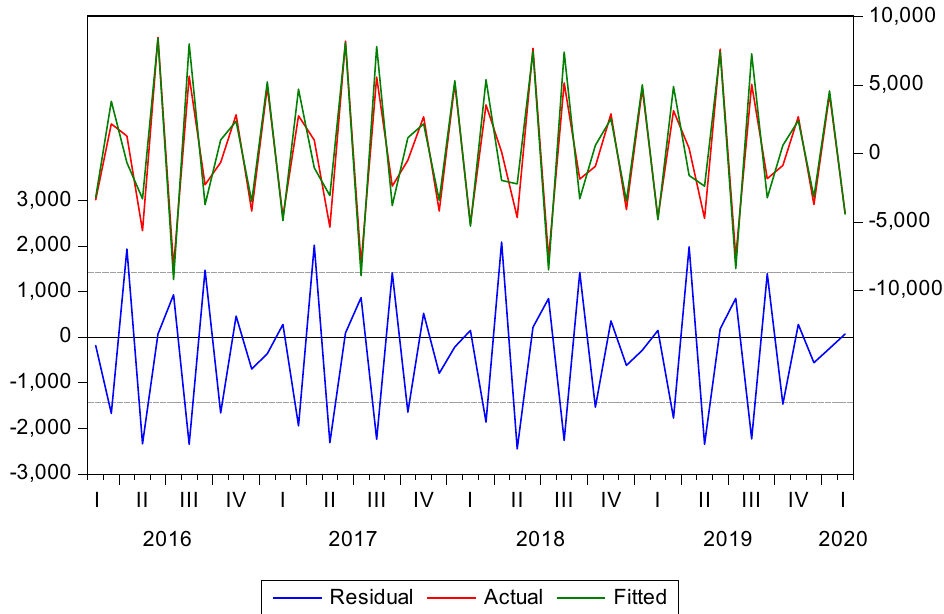
Figure 7. Comparison of real enotourism (actual), estimated enotourism (fitted) and errors (residual). Source. Own elaboration.